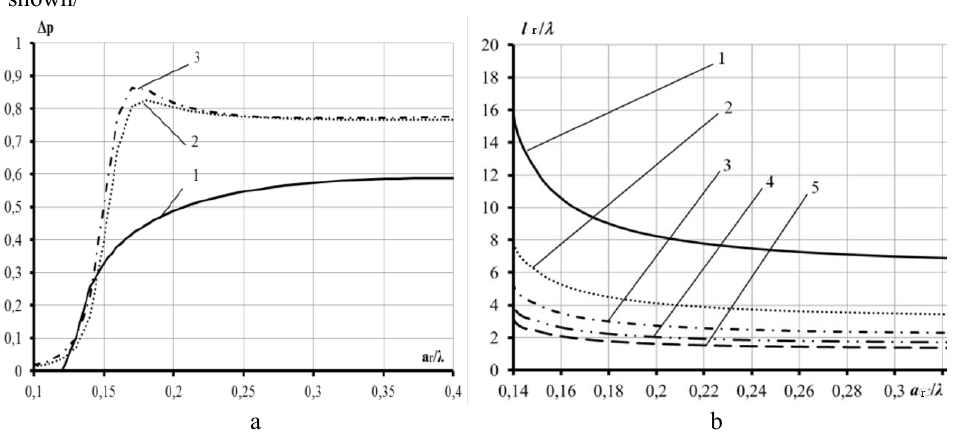
Fig. 4. Functions of phase structure activity  р( а r /  ) while  2 =0,15 (а) and length l r ( а r /  ) with different numbers of  2